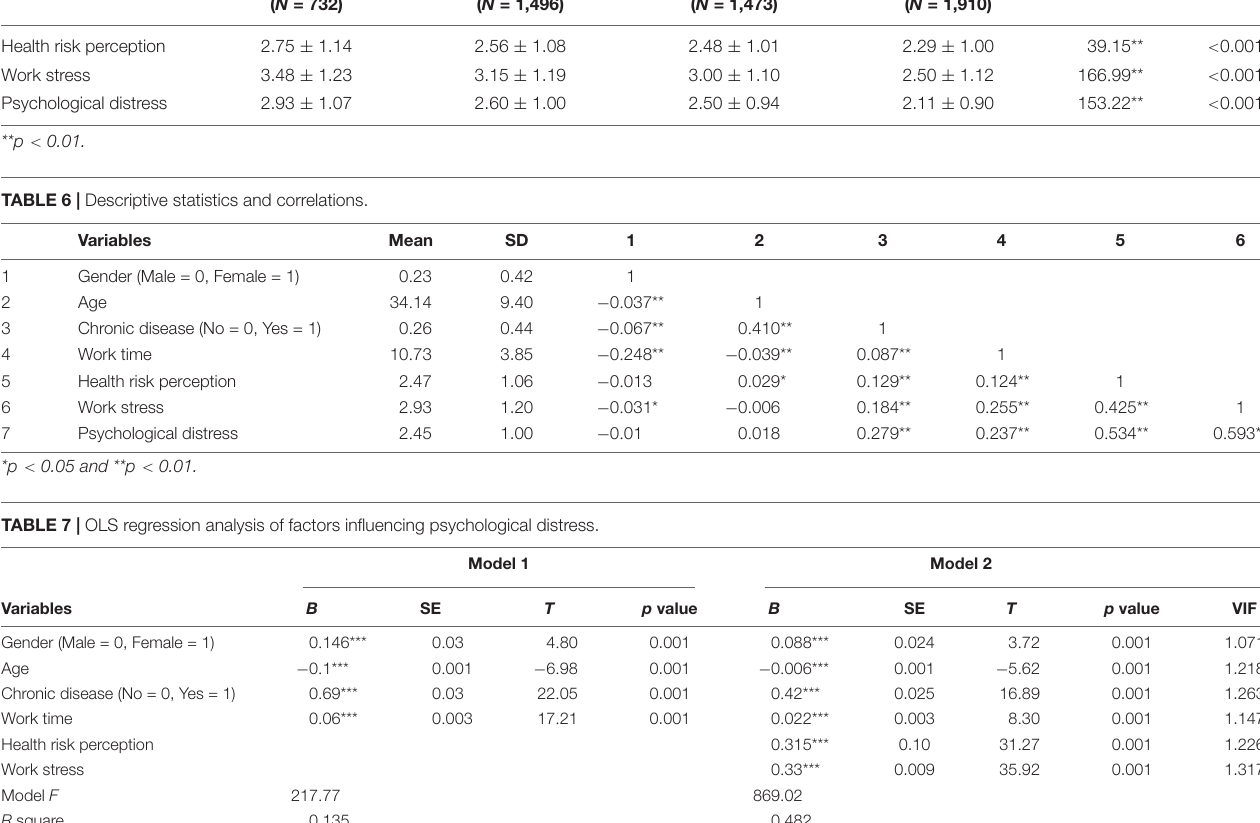
TABLE 5 | One-way ANOVA of health risk perception, work stress, and psychological distress among different work time groups. Variables Above 14 h ( N = 732)